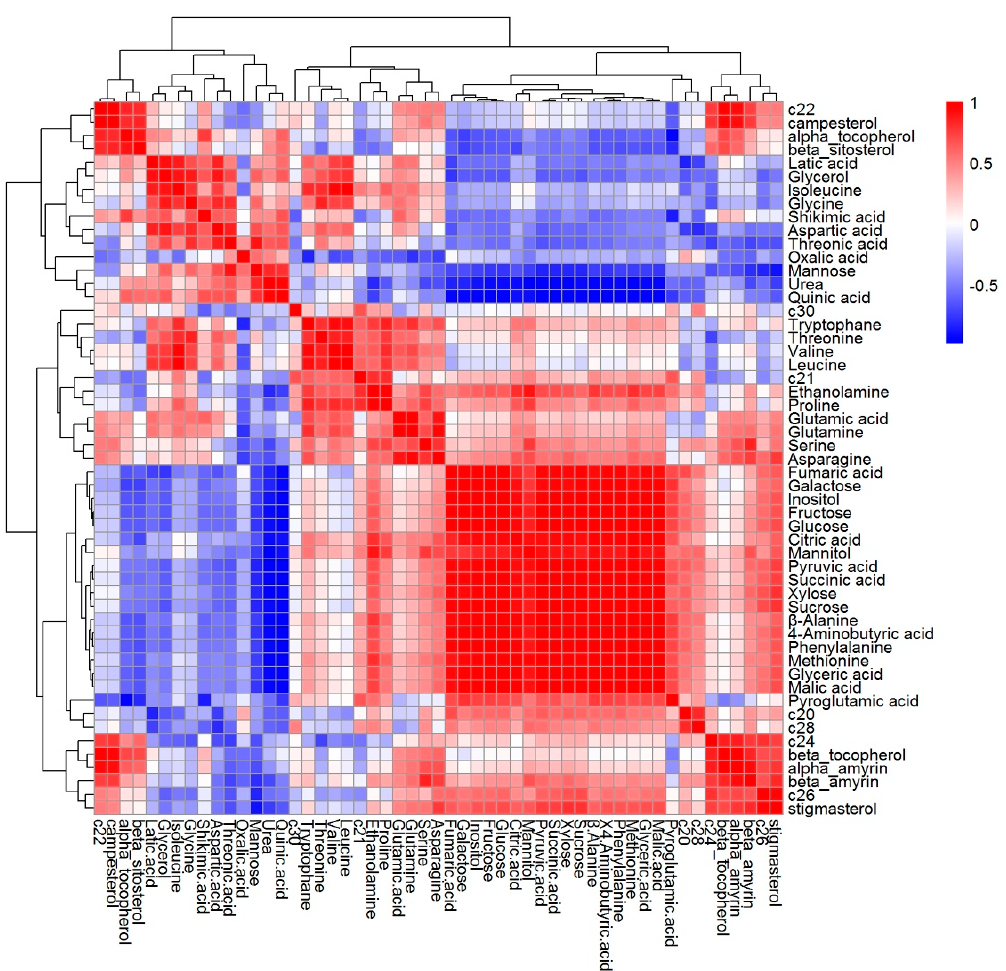
Figure 6. Correlation matrix and cluster analysis of results obtained from data on 53 primary metabolites of buckwheat. Each square indicates the Pearson’s correlation coefficient of a pair of compounds and the value for the correlation coefficient is represented by the intensity of the blue or red color, as indicated on the color scale.